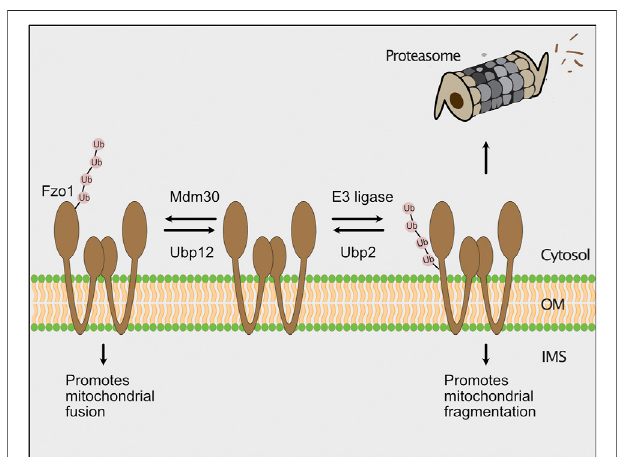
FIGURE 5 | The ubiquitin-proteasome system regulates mitochondrial fusion. In yeast, the GTPase Fzo1 (fuzzy onion) promotes fusion of mitochondria. The F-box protein Mdm30 mediates ubiquitylation of Fzo1 at speci fi c lysines to stimulate mitochondrial fusion. Fusion-promoting ubiquitylationisreversedbythedeubiquitylatingenzymeUbp12. Alternatively, an unknown E3 ubiquitin ligase ubiquitylates Fzo1 on different lysine residues, which leads to its proteasomal turnover. The degradation of Fzo1 inhibits fusion and results in mitochondrial fragmentation due to ongoing fi ssion. Proteolytic ubiquitylation of Fzo1 is inhibited by the deubiquitylating enzyme Ubp2.